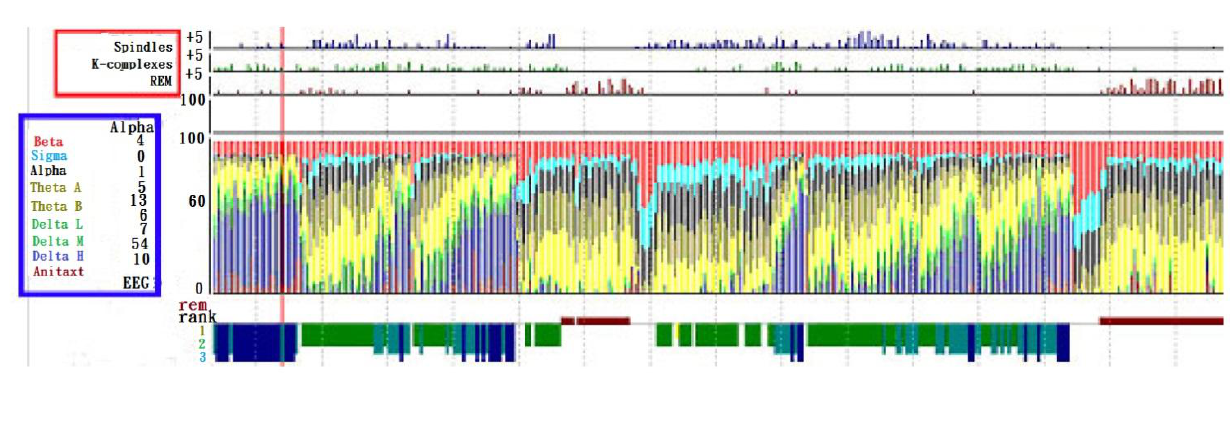
Figure 9. Sleep stage recognition according to brain